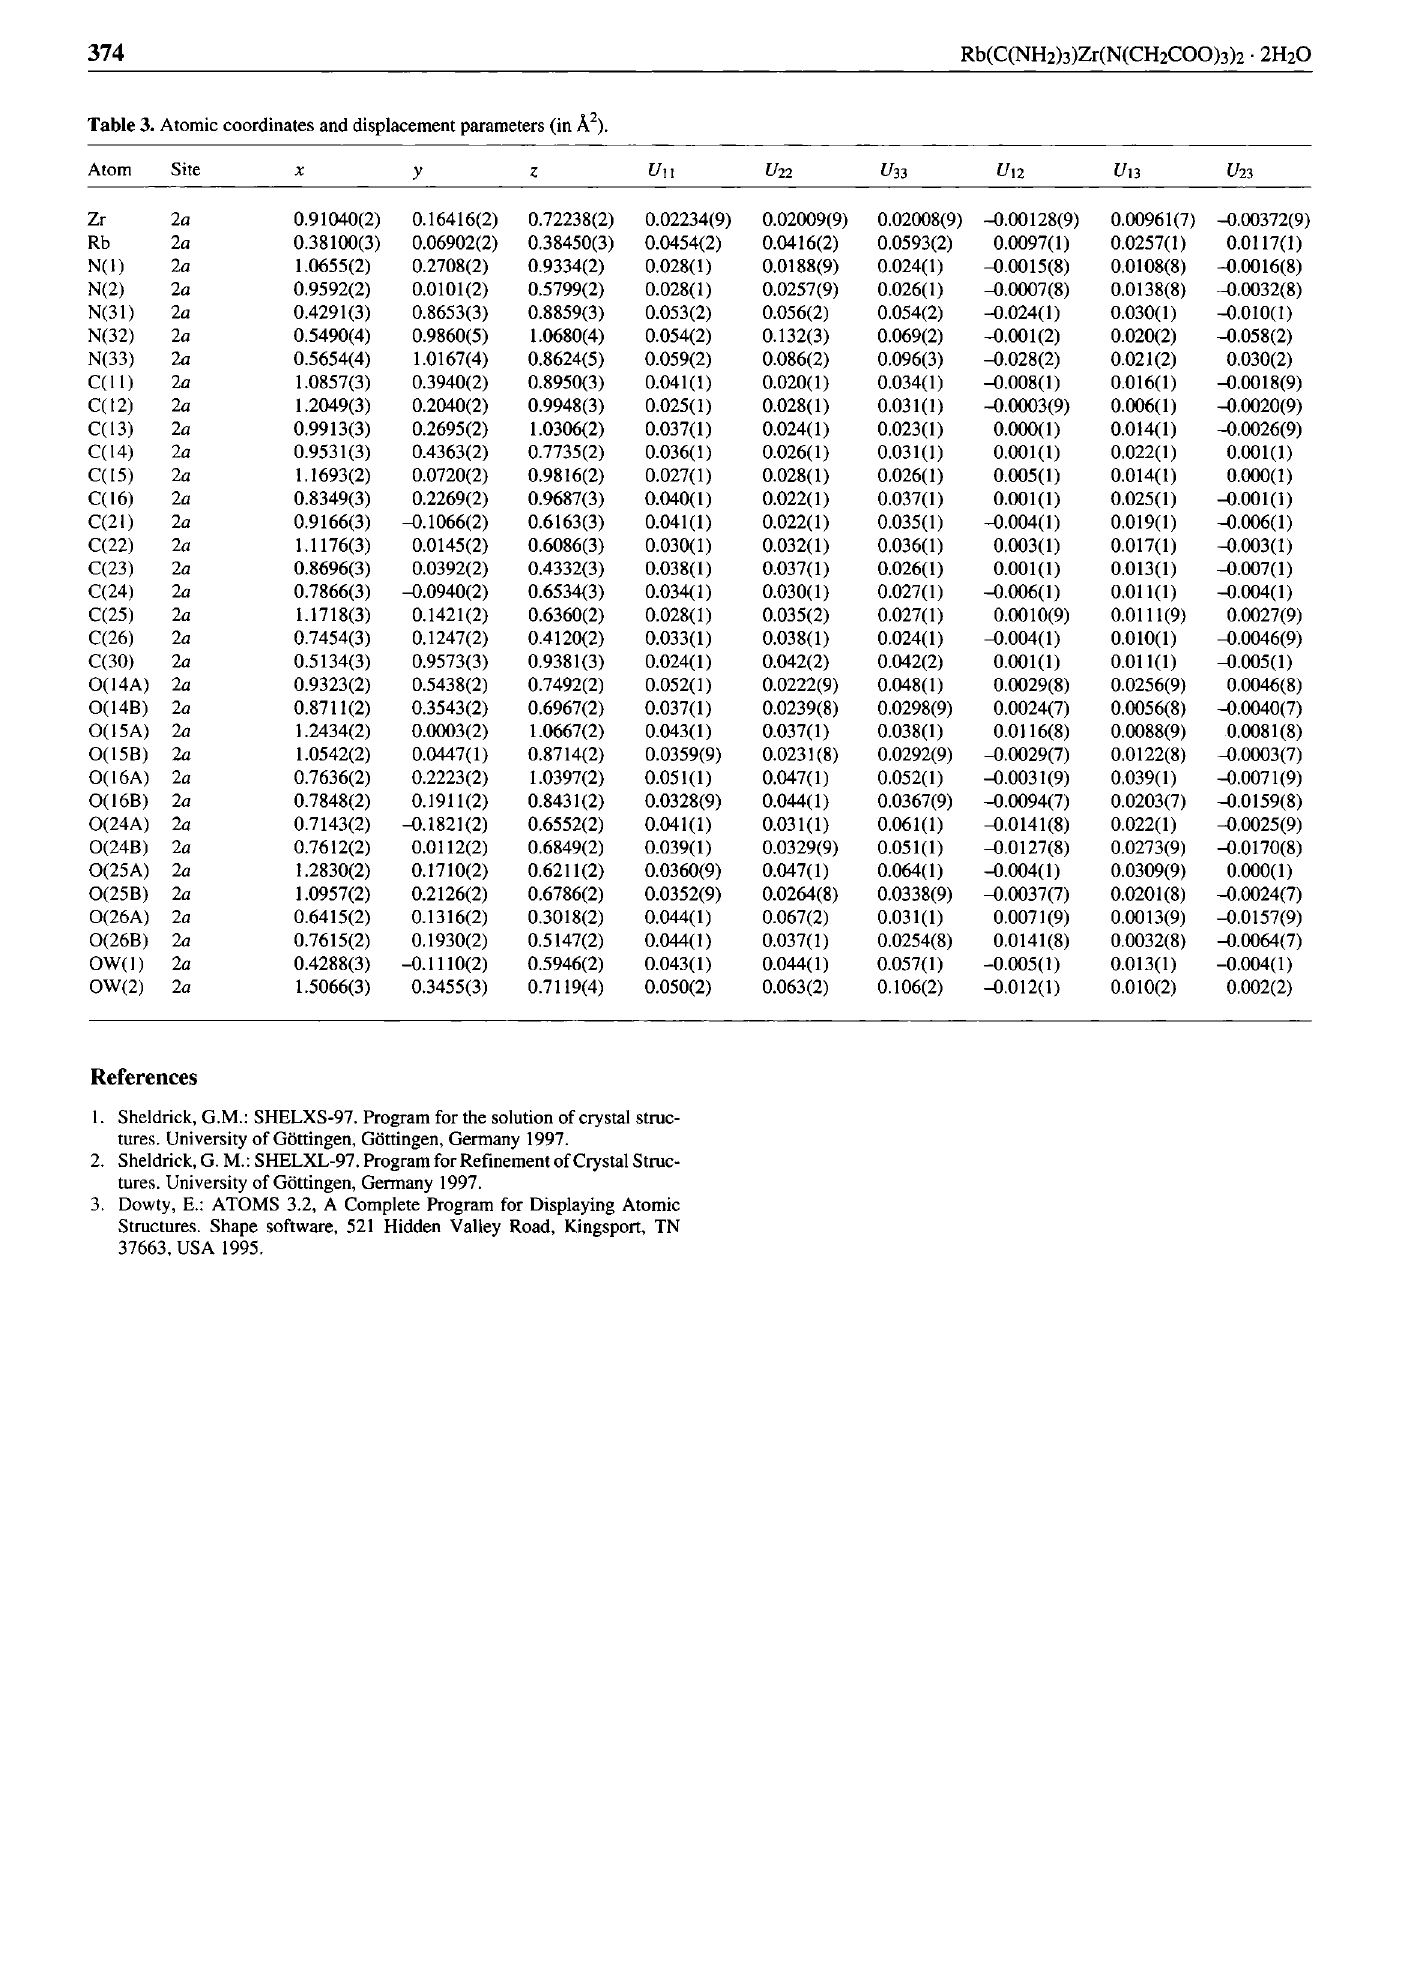
Table 3. Atomic coordinates and displacement parameters (in Ä 2